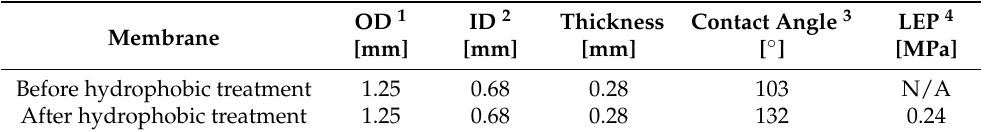
Table 1. Membrane properties.